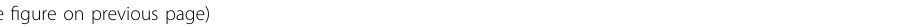
Fig. 1 Micro-heterogeneity of SCA-1 in fi bro/adipogenic progenitors. a Schematic representation of the work fl ow applied to study FAP heterogeneity. Cells are taken from Servier Medical Art (SMART), under Creative Commons Attribution 3.0 Unported License. b Representative viSNE maps of total mononuclear cells isolated from young wild type and mdx mice. The four clusters produce by FlowSOM algorithm were mapped onto the viSNE maps and correspond to the following mononuclear cell populations: FAPs (blue), endothelial cells (orange), leucocytes (green) and muscle satellite cells (MuSCs, red). c Representative Self-Organising Maps (SOMs) of FAPs identi fi ed in (a) . SOMs were obtained with the FlowSOM algorithm. Each node represents a cluster of cells, nodes with similar expression pro fi le are linked by an edge. Colour of nodes indicate SCA-1 expression level. Node outlines indicate the four metaclusters (red, blue, black and green) obtained by the algorithm. Red and blue shadings highlight FAPs expressing high levels (red and blue metaclusters, called SCA1-High-FAPs) and low levels (black and green metaclusters, called SCA1-Low-FAPs) of SCA-1. d Stacked bar plot showing the fraction of SCA1-High-FAPs and SCA1-Low-FAPs in wild type and mdx mice. Data are presented as mean ± SEM. Statistical signi fi cance was estimated by a One-way ANOVA, * p ≤ 0.05, ** p ≤ 0.01 ( n = 4). e Representative SCA-1 histograms of FAPs from wild type and mdx mice identi fi ed in ( b ) and their standard deviations (SD) showing a typical micro-heterogeneity pro fi le. f Sorting strategy to decompose SCA-1 micro-heterogeneity and to isolate SCA1-High-FAPs and SCA1-Low-FAPs from mdx mice. Complete strategy, Fluorescence minus one (FMO) controls and cell states purity in Supplementary Fig.